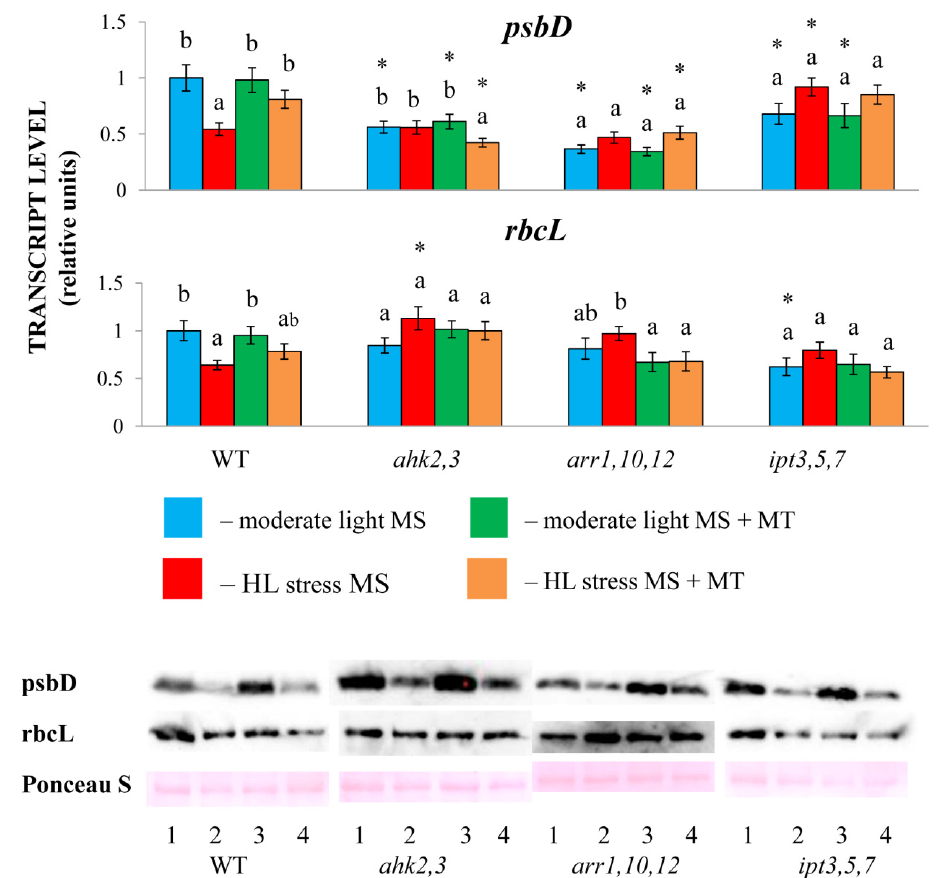
Figure 2. Effect of HL stress and melatonin treatment on the expression of chloroplast genes and corresponding proteins. 1—moderate light MS; 2—HL stress MS; 3—moderate light MS +